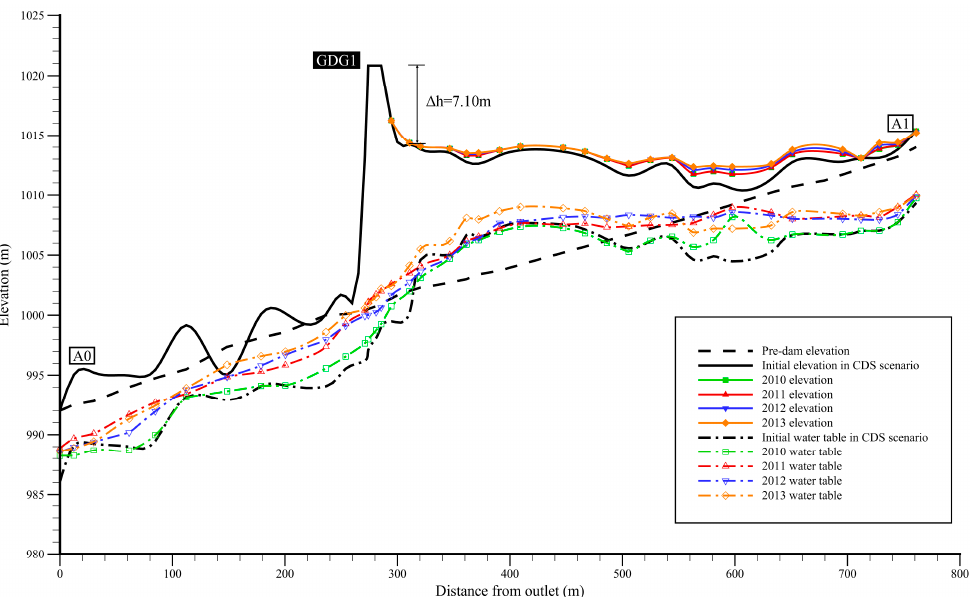
Figure 10. Surface elevation changes and water table changes of GDG1 dam-controlled reach during CDS scenario. Note that the simulation results in the end of month 11 of each year were used for comparison.